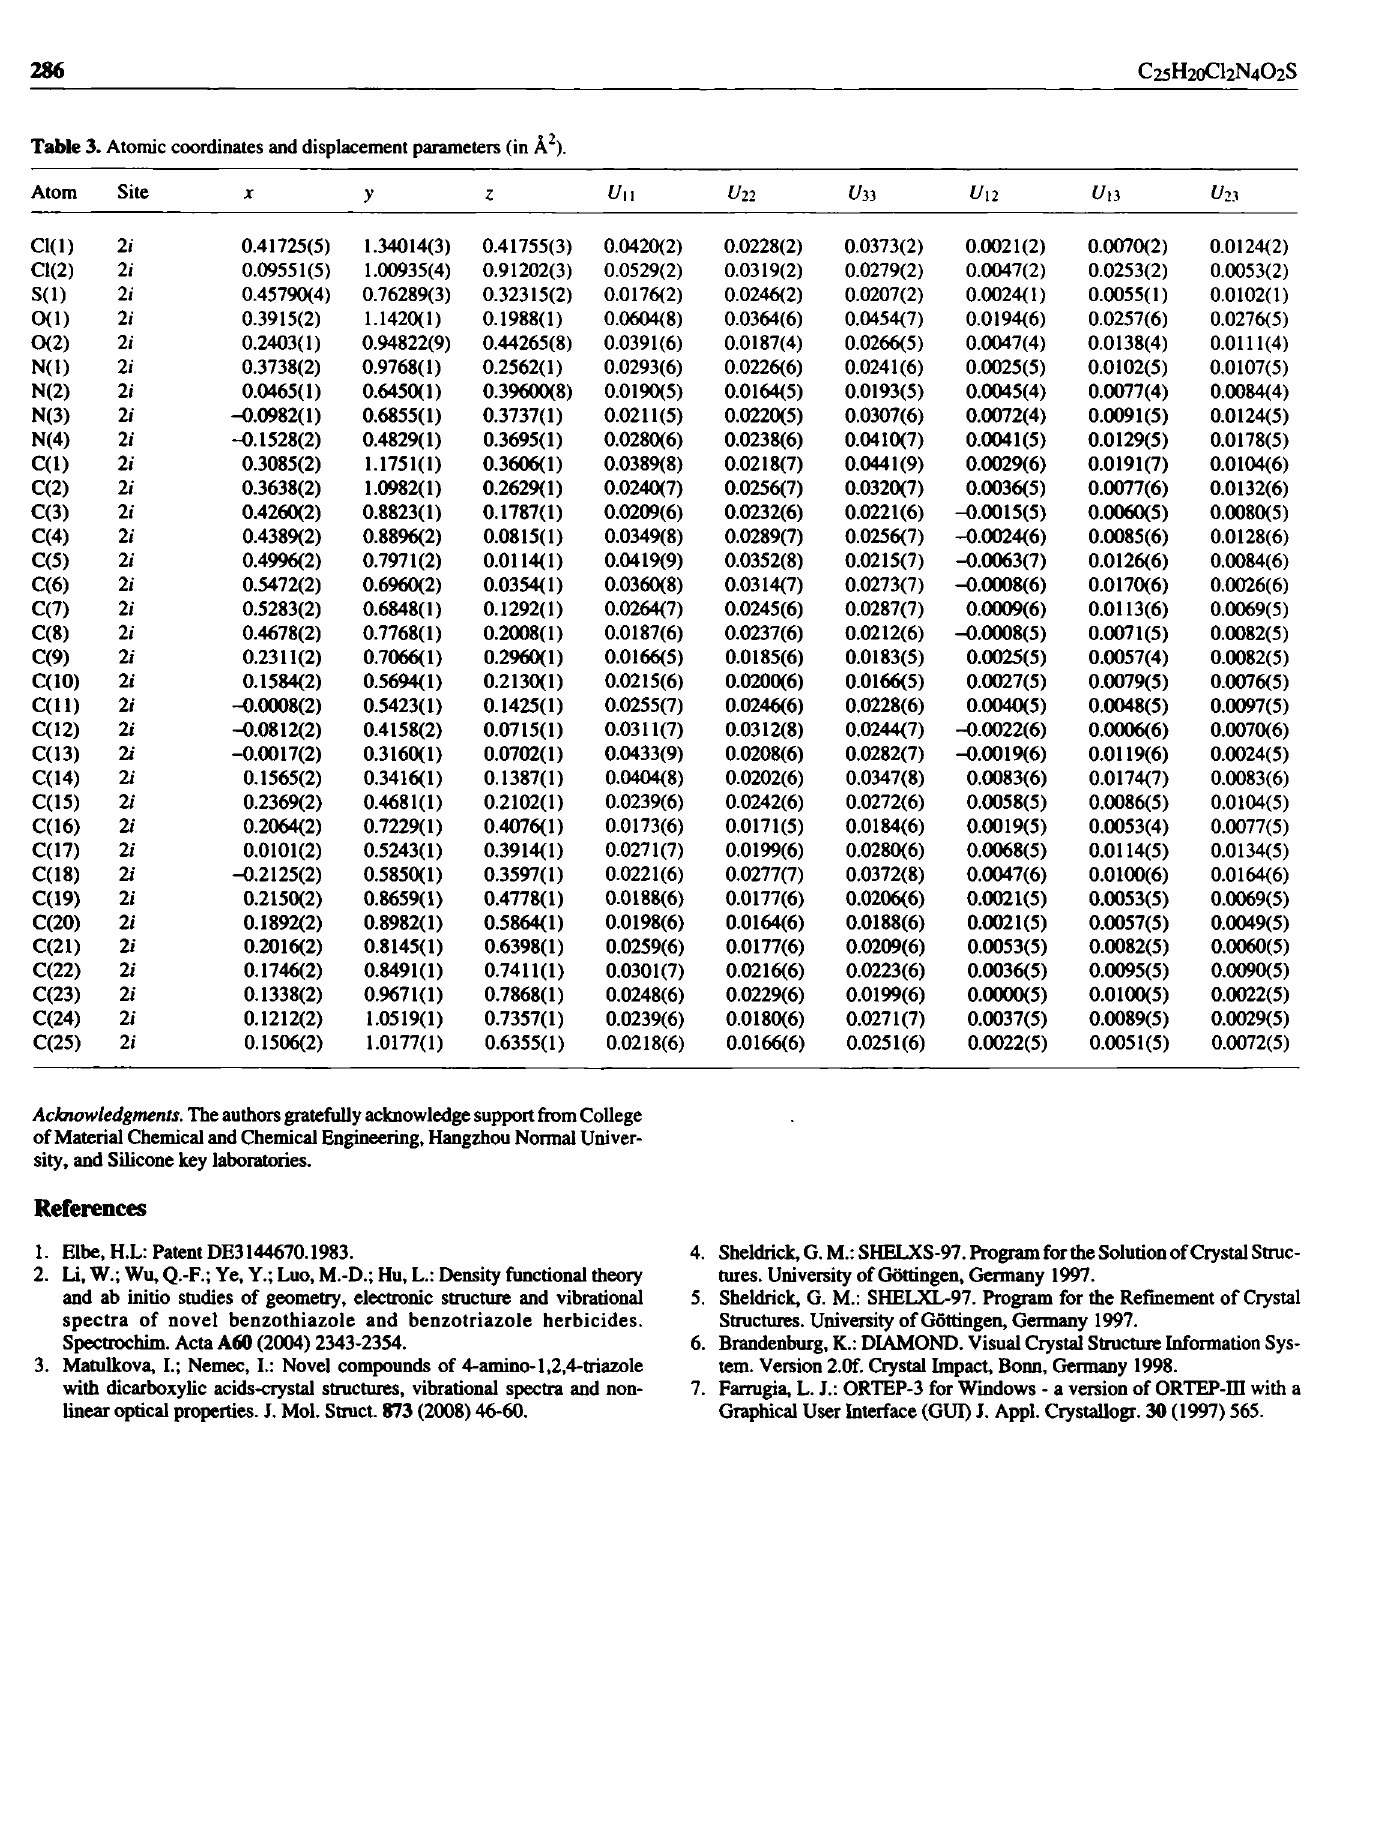
Table 3. Atomic coordinates and displacement parameters (in Ä 2